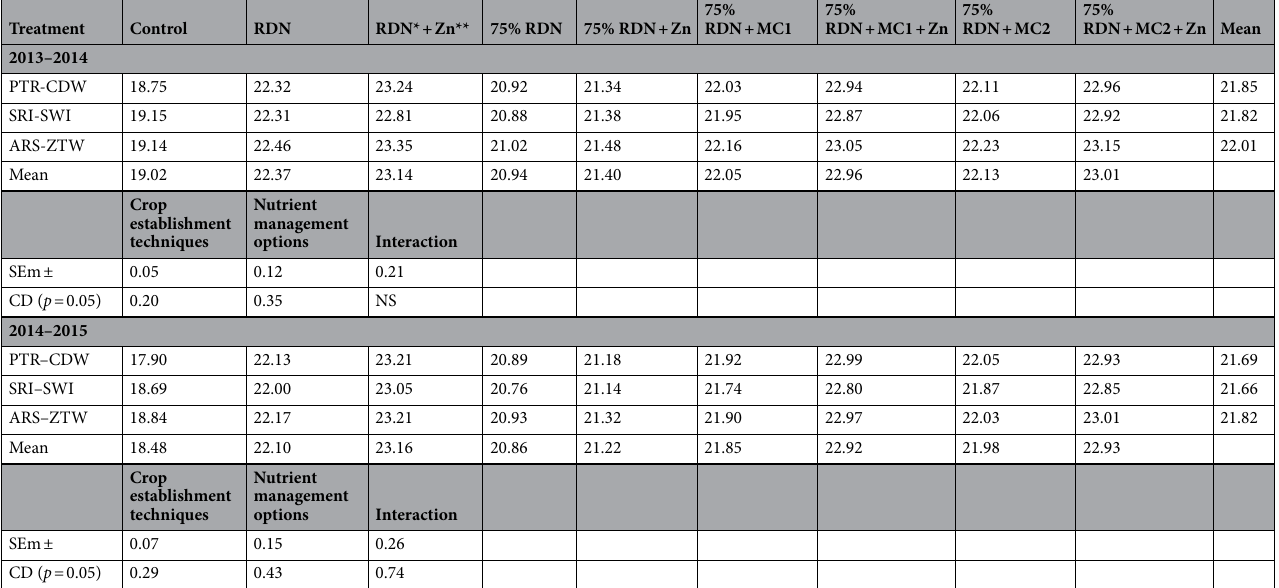
Table 1. Influence of crop establishment techniques and nutrient management options on biological yield (Mg ha −1 ) of rice–wheat cropping system during 2013–2014 and 2014–2015. PTR , puddled transplanted rice; SRI , system of rice intensification; ARS , aerobic rice system; CDW , conventional drill-sown wheat; SWI , system of wheat intensification, ZTW , zero tillage wheat; RDN* , recommended dose of nutrients [120 kg nitrogen ha